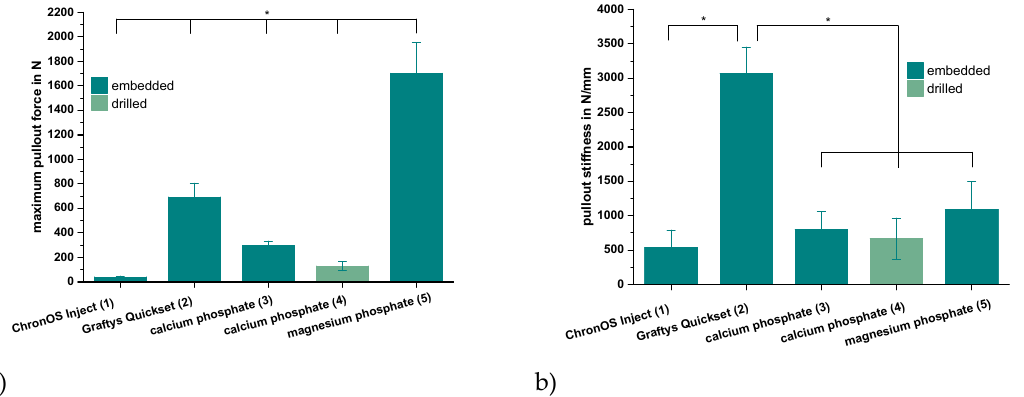
Figure 8. Maximum pullout force and pullout sti ff ness. Highest pullout force for the MPC and highest pullout sti ff ness for Graftys ® : Maximum force ( a ) and sti ff ness ( b ) while pulling out cortical screws from a cylindrical matrix based on commercial ChronOS TM Inject (group 1), Graftys ® Quickset (group 2) and in-house-prepared dual setting calcium phosphate (groups 3,4) and magnesium phosphate (group 5) after 24 h of setting in water at 37 ◦ C. Only in the case of the dual setting calcium phosphate, the cement matrix sustained tapping and drilling (group 4), whilst in all other cases, the screws had to be embedded in the unhardened matrix. All di ff erences between the single groups were significant for the maximum pullout force ( a ). Graftys ® Quickset showed the significantly highest sti ff ness values of all experimental groups. Significant differences (*) were set at p < 0.01 each.